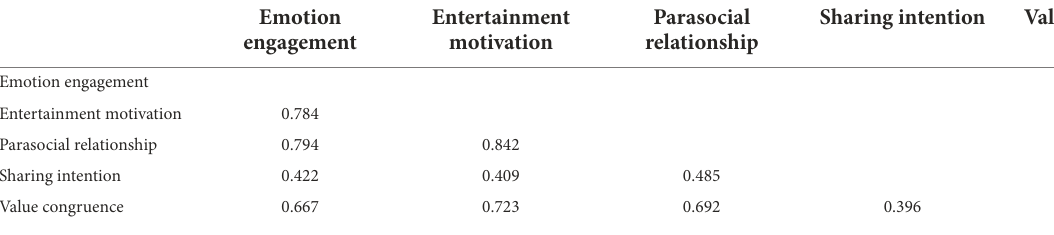
TABLE 4 Heterotrait–Monotrait Ratio of Correlations (HTMT) analysis.